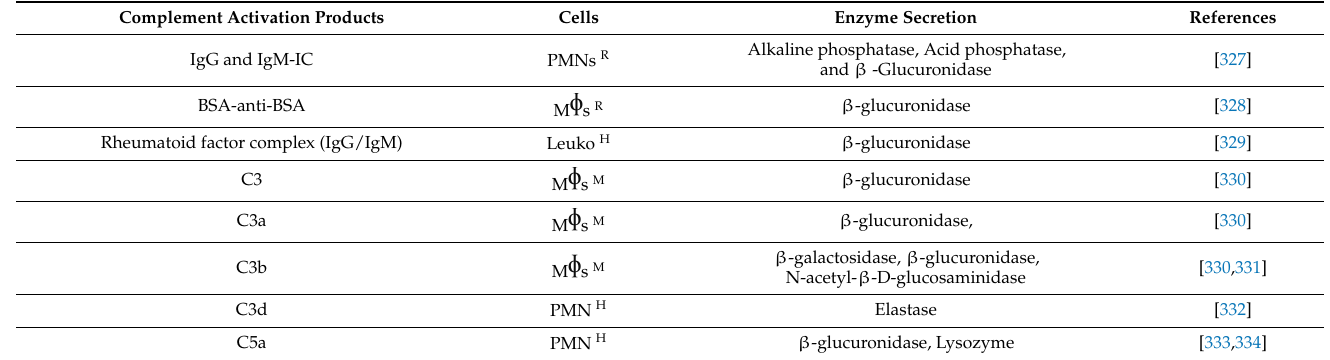
Table 7. Immune cell stimulation with immune complexes or compliment activation products trigger excess release of several